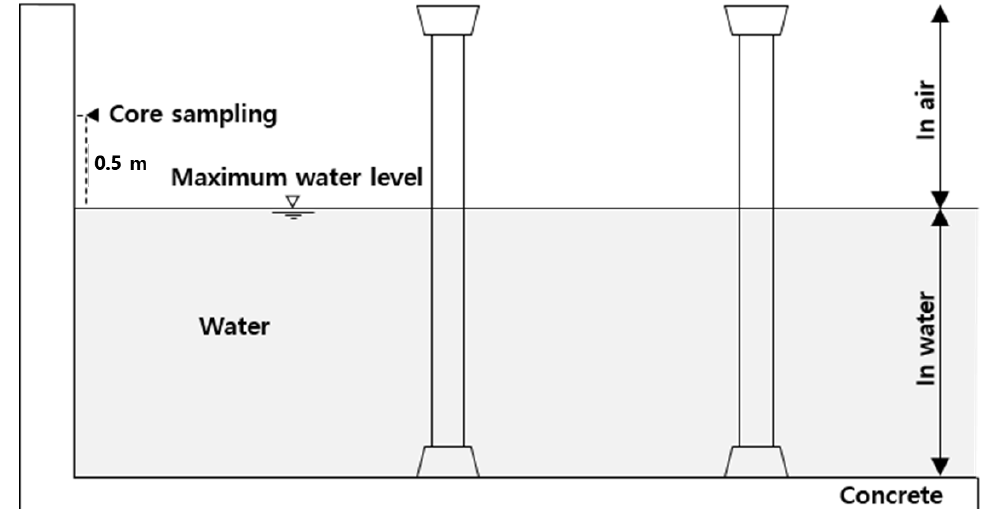
Figure 1. Conceptual diagram of core sampling location in the water reservoir.